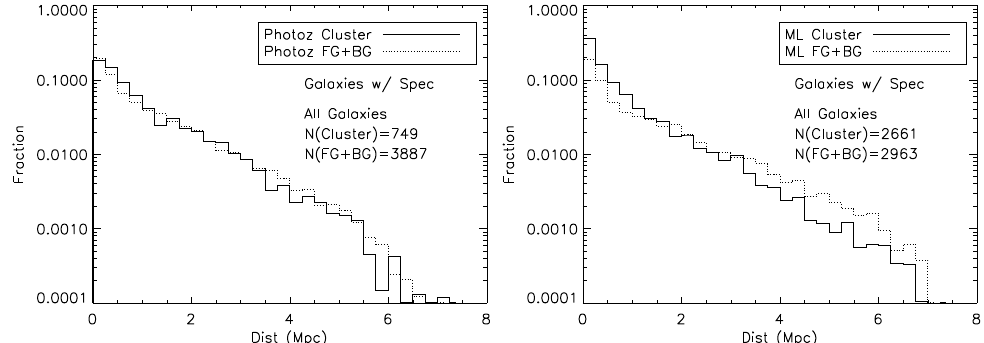
Figure 10. Distributions of cluster memberships assigned by the SDSS photometric redshifts as a function of cluster-centric distance ( left panel) and distributions of cluster memberships assigned by our ML (MLP best model) as a function of cluster-centric distance ( right panel), both corresponding to our sample with